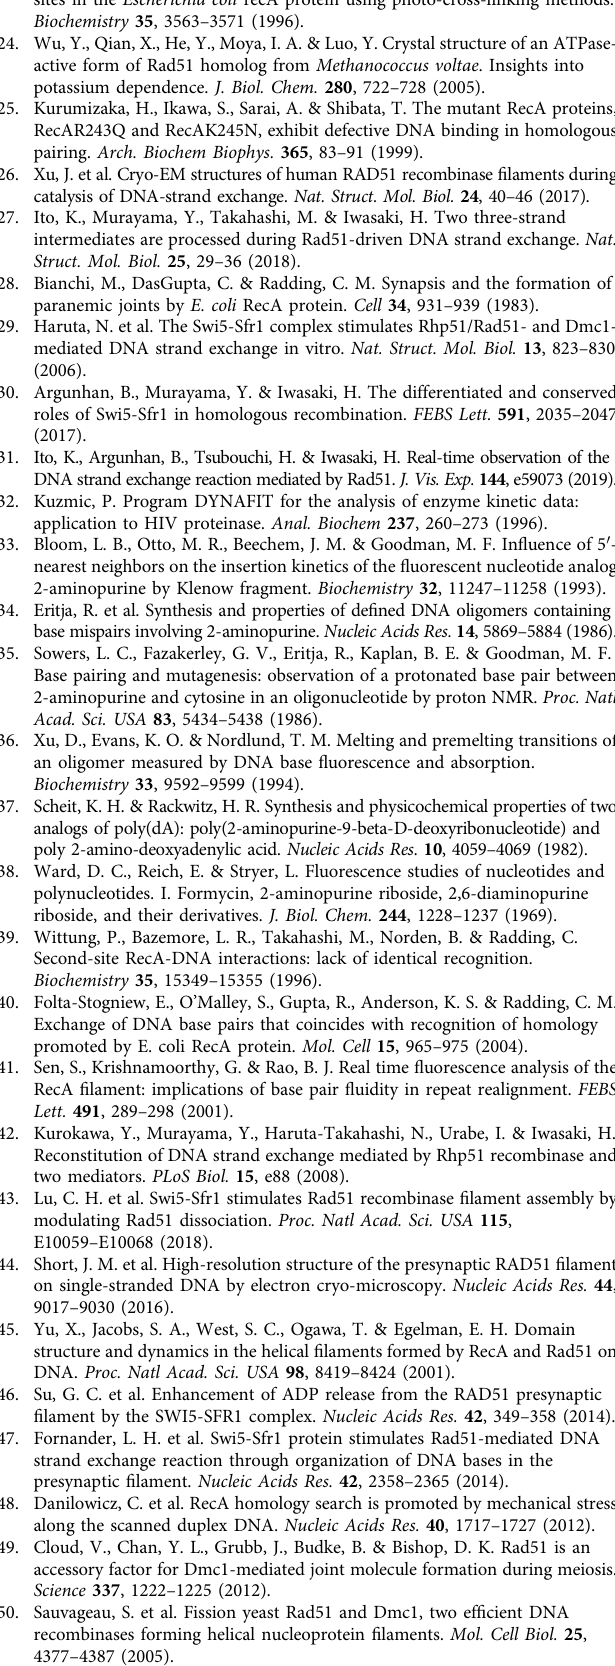
Table S7, Table S8, Table S9 and Table S10 are provided as a Source data fi le_3. The Source data for Figs. 1b and 7b (the structural model of Rad51-ssDNA fi lament) are provided as a Source data fi le_4. The Source data for Fig. 1c and 7b (the structural model of Rad51-dsDNA fi lament) are provided as a Source data fi le_5. The Source data for Fig. 7b (the structural model of C1 complex) is provided as a Source data fi le_6. The source data for Fig. 7b (the structural model of C2 complex) is provided as a Source data fi le_7. The Source data for Fig. S6a (the structural model of three-strand complex with a steric hindrance) is provided as a Source data fi le_8. The model structures have been submitted to the Biological Structure Model Archive (BSM-Arc) under BSM-ID BSM00017 (https://bsma.pdbj.org/entry/17). Thus, all data supporting the fi ndings